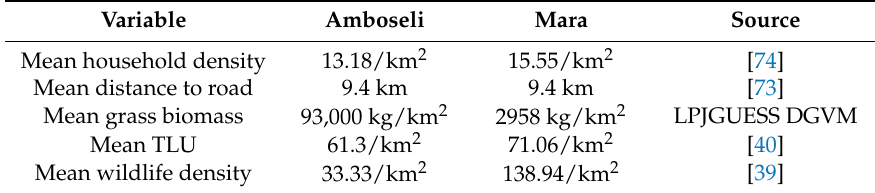
Table A1. Initialization state variable